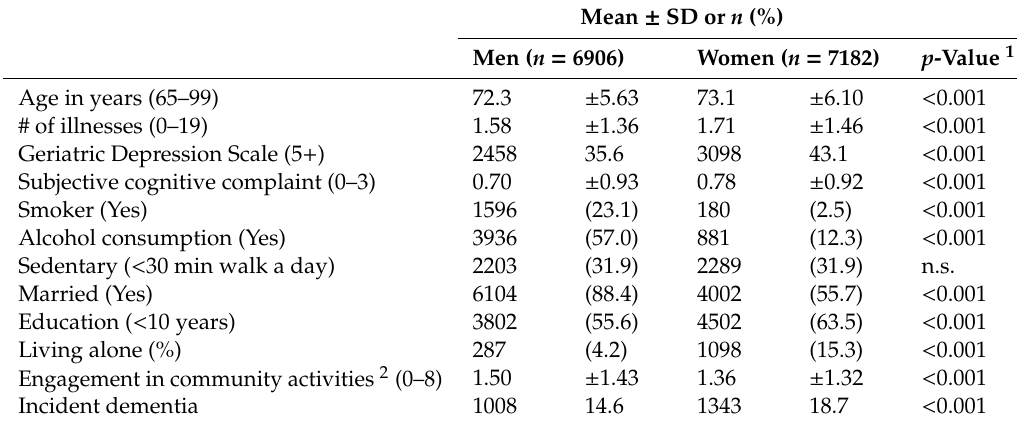
Table 1. Baseline characteristics by gender.